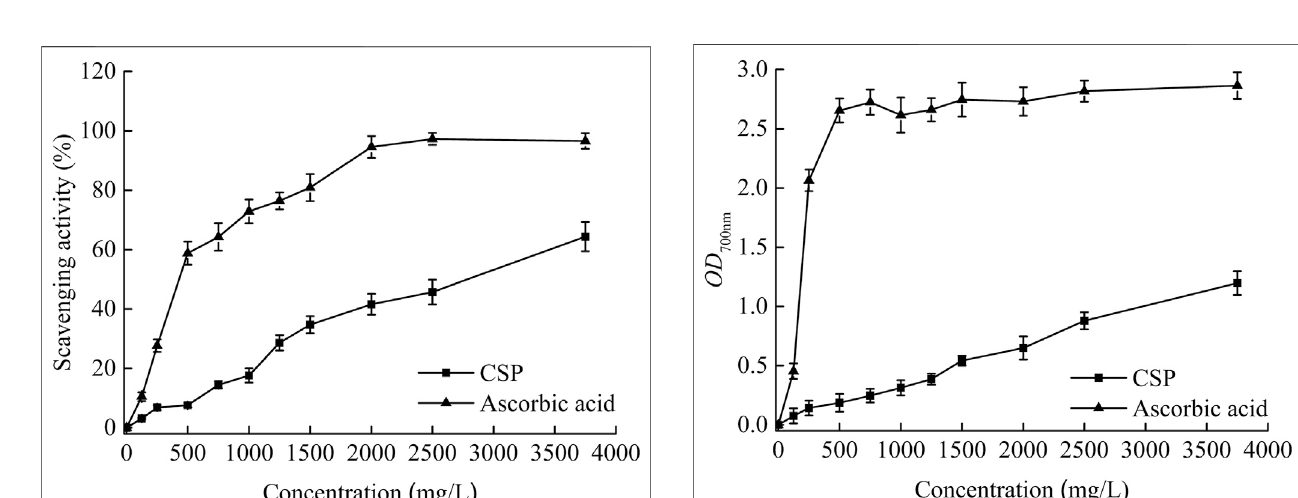
FIGURE 2 | Scavenging effects on hydroxyl radicals of CSP.